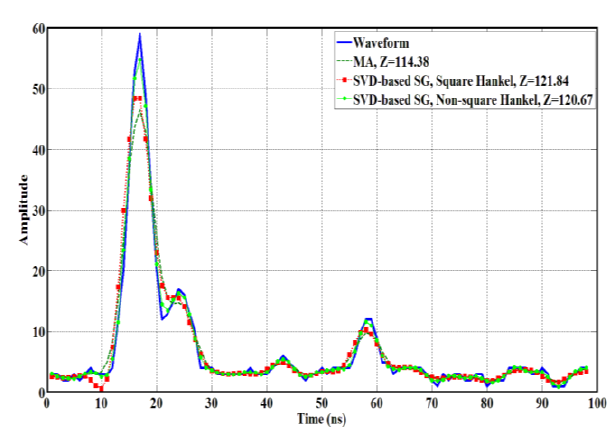
Figure 8. Comparison of the SVD-based S-G smoothing results together and with the